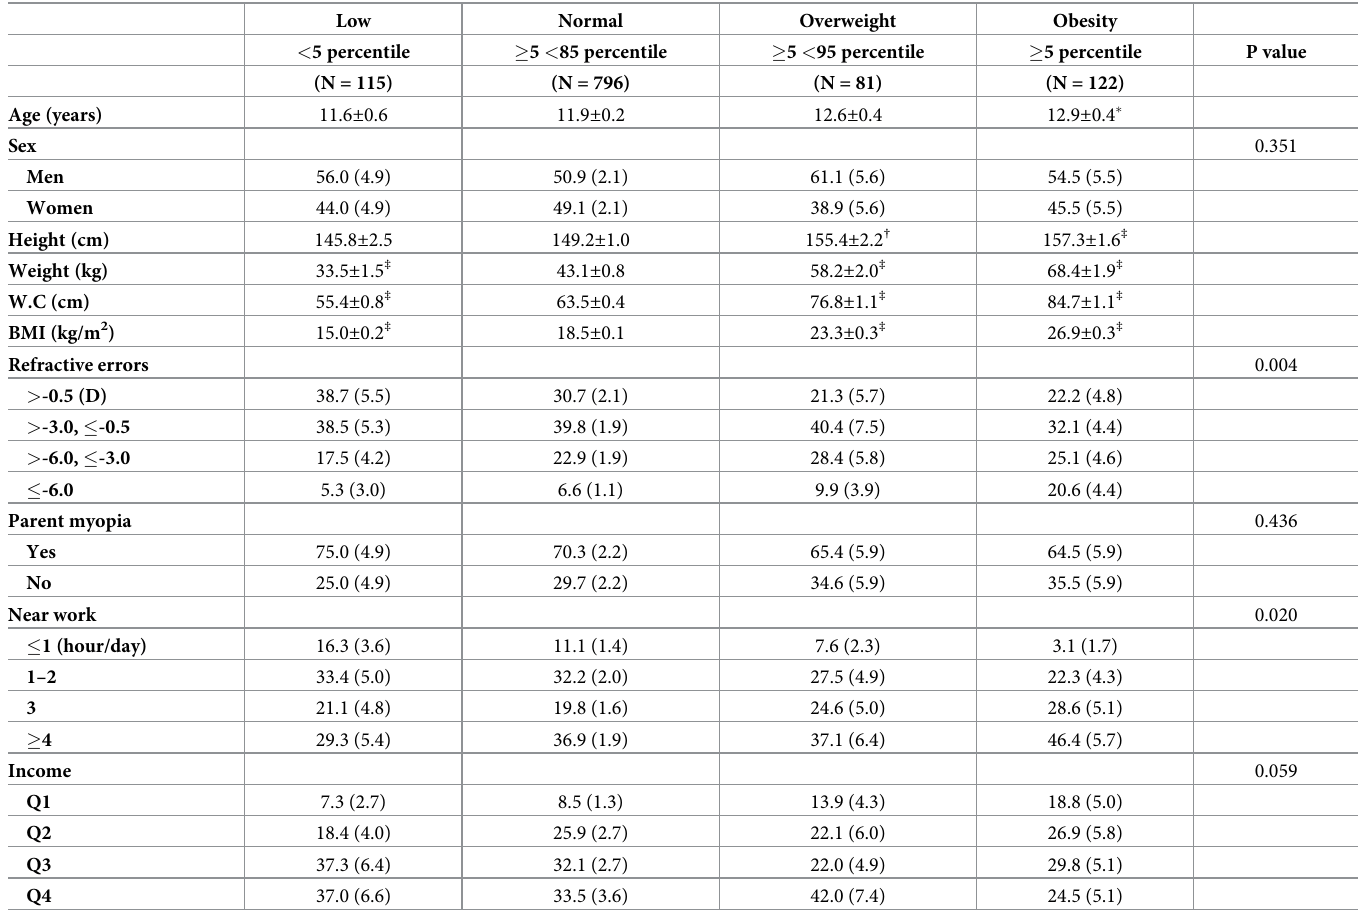
Table 1. Characteristics of the subjects according to BMI percentile.